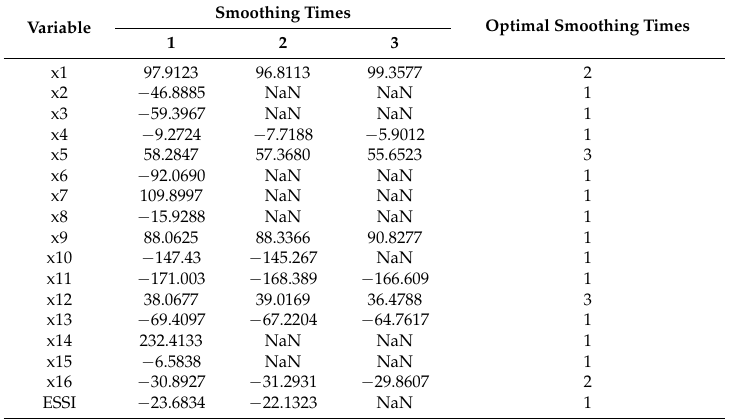
Table 8. BIC values of energy supply sustainability and its